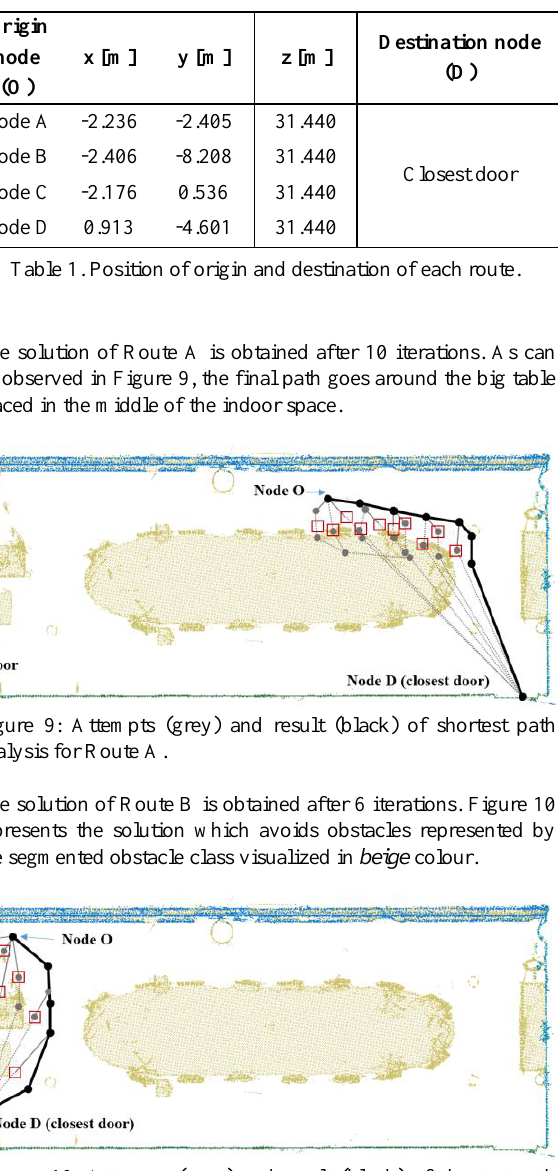
Figures 10: Attempts (grey) and result (black) of shortest path analysis for Route B.